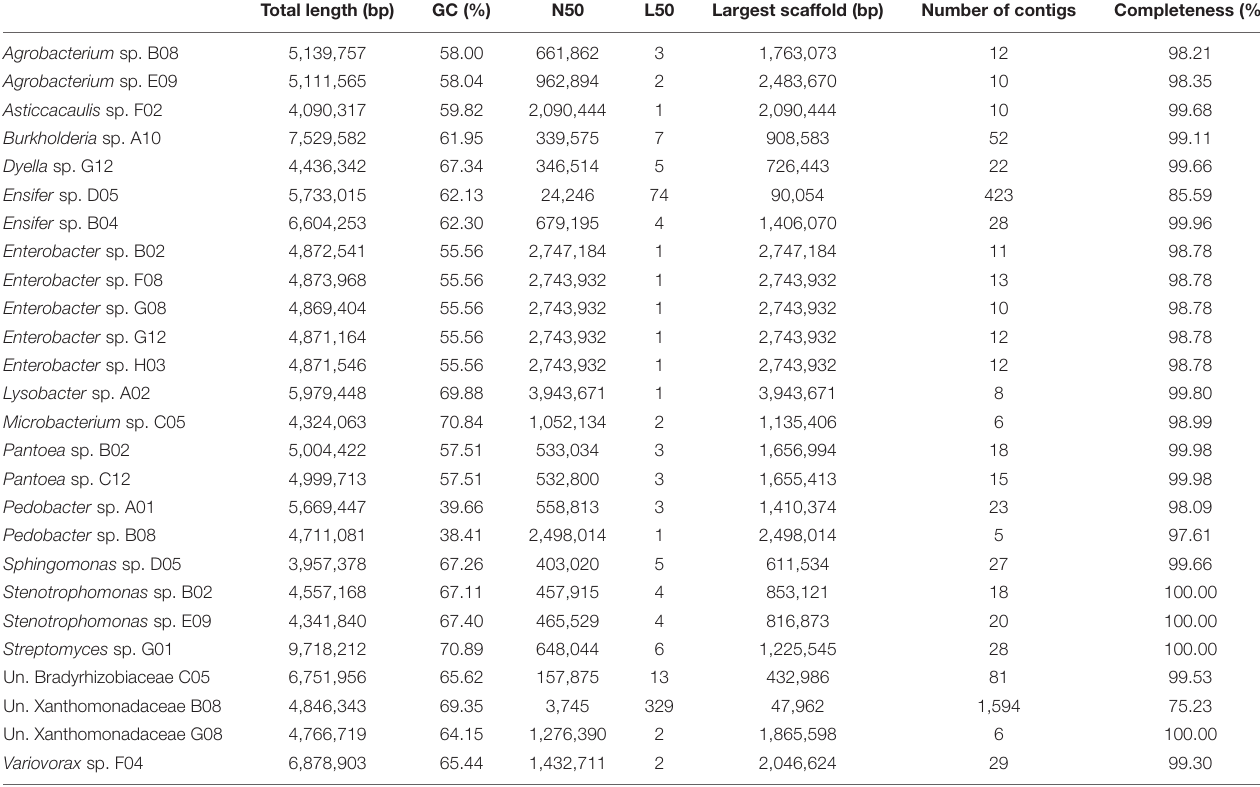
Largest scaffold (bp) Number of